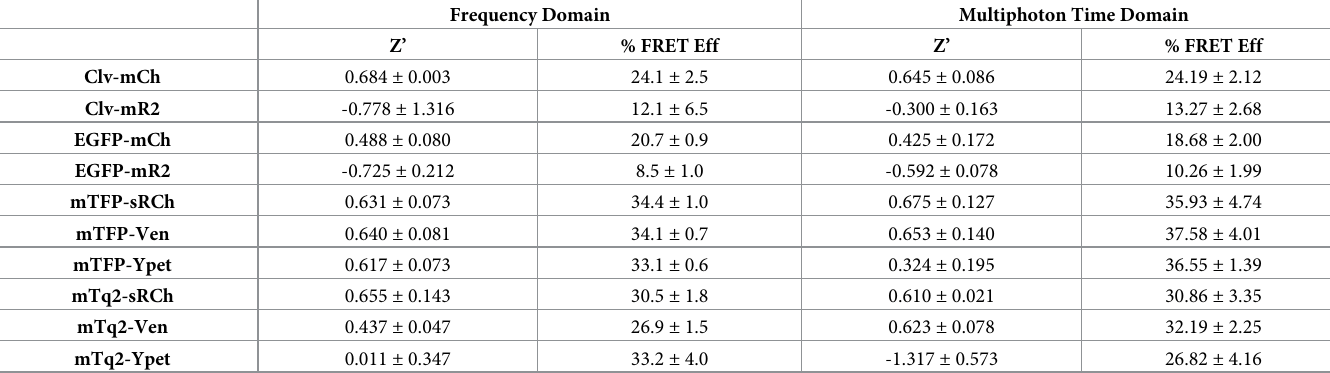
Table 3. Assay potential (Z’) and FRET efficiency under frequency and time domain FLIM conditions at t = 0.